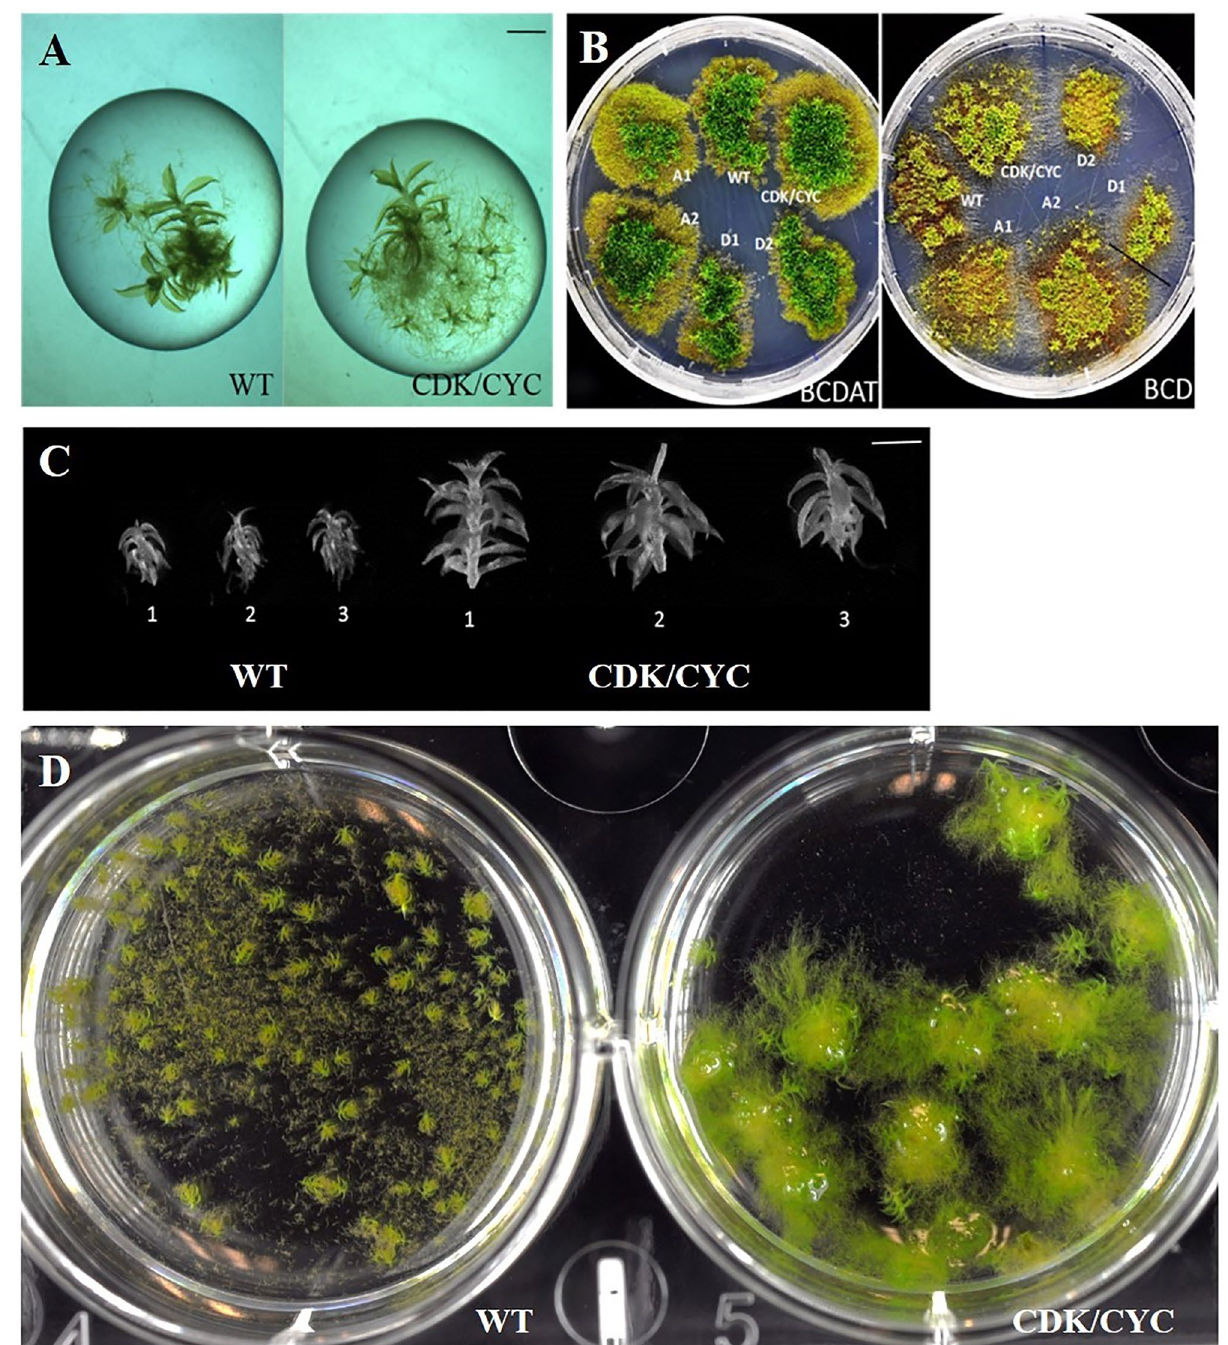
Figure 4. ( A ) Comparison of a single gametophore of WT and the transgenic line grown in BCD liquid medium for 35 days (scale bar = 0.6 mm). ( B ) Homogenized cell lines studied in this work were grown for 90 days on BCDAT and BCD solid media for phenotypic comparison. ( C ) Comparison of gametophore phenotype of WT and ZmUbi:PpCKA1–PpCDKA2–OsAct:PpCYCD2–PpCYCD1 biological triplicate lines grown under same conditions for 35 days (scale bar = 0.6 mm). ( D ) Comparison of a single gametophore of WT and ZmUbi:PpCKA1–PpCDKA2–OsAct:PpCYCD2–PpCYCD1 grown in BCD liquid medium for 90 days, in six well microtiter